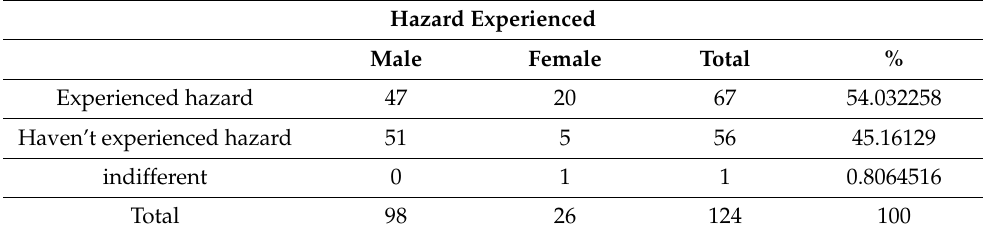
Table 2. Hazards experienced during waste picking.